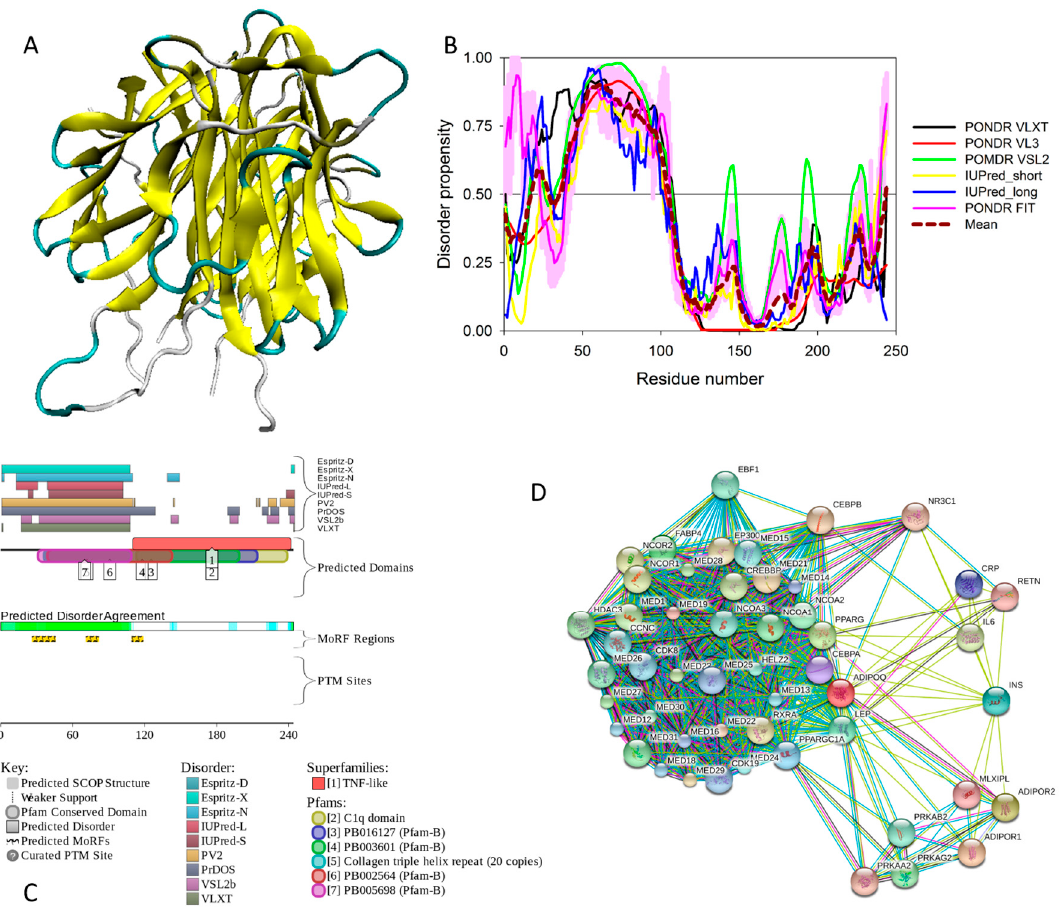
Figure 12. Structure and intrinsic disorder in human adiponectin (UniProt ID: Q15848). ( A ) Crystal structure of a single-chain trimer of human adiponectin globular domain (PDB ID: 4DOU). ( B ) Evaluating intrinsic disorder propensity of human adiponectin by series of per-residue disorder predictors. Disorder profiles generated by PONDR ® VLXT, PONDR ® VSL2, PONDR ® VL3, IUPred_short, IUPred_long, and PONDR ® FIT. ( C ) Analysis of the intrinsic disorder propensity and some important disorder-related functional information generated for human adiponectin by the D 2 P 2 database (available online: http://d2p2.pro/). ( D ) Analysis of the interactivity of human adiponectin by STRING computational platform.